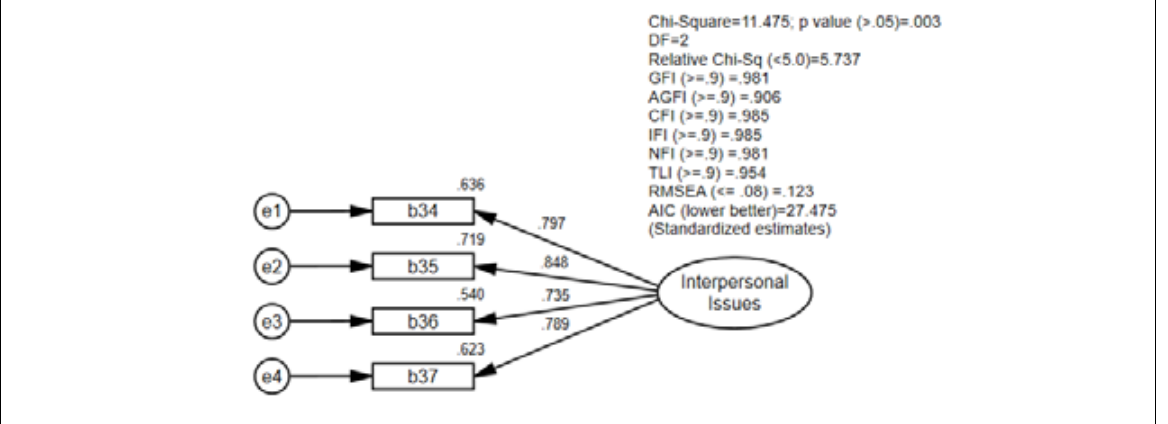
Figure 5. Confirmatory Factor Analysis for Interpersonal